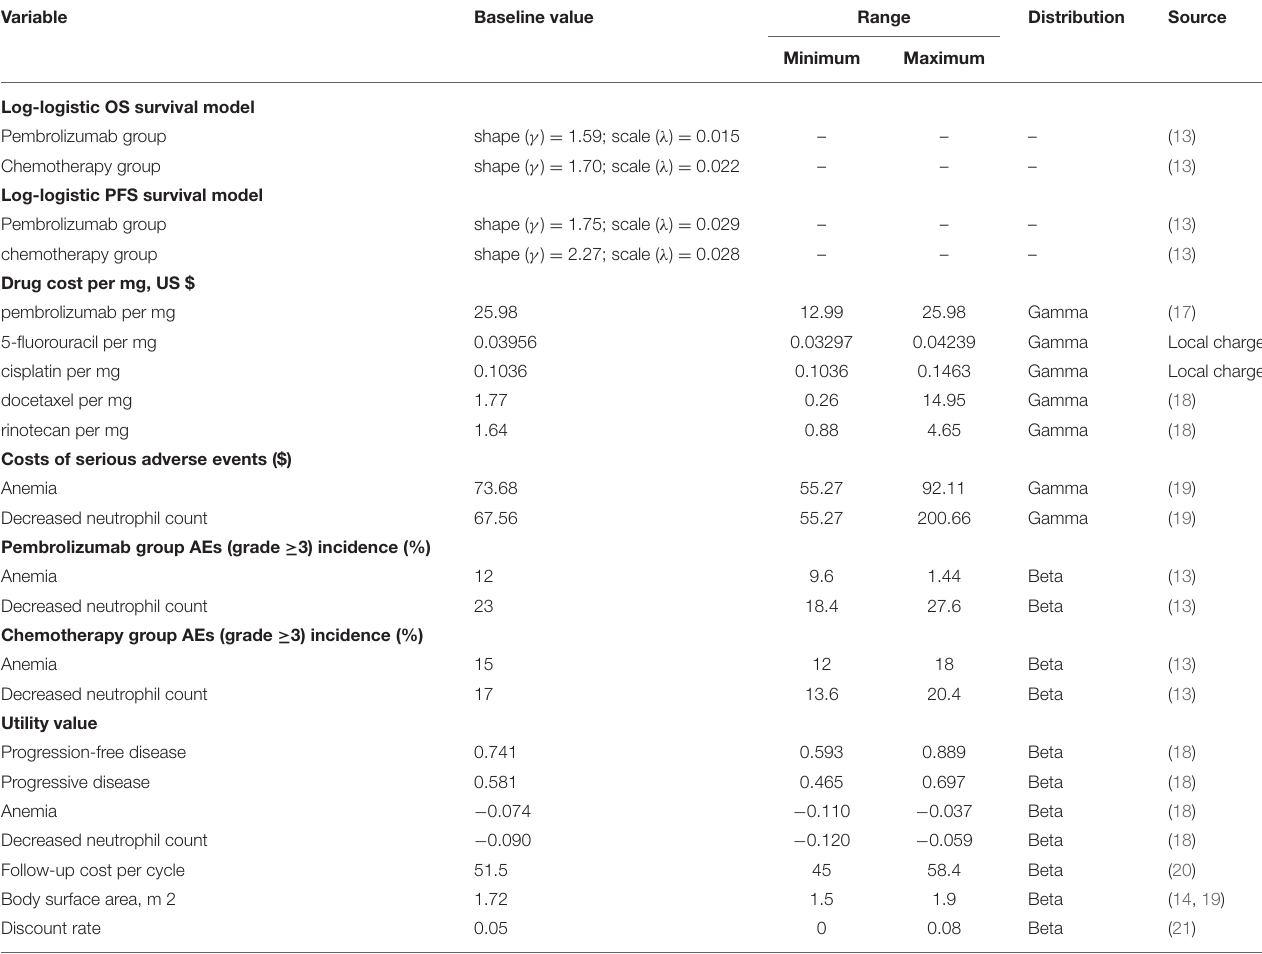
TABLE 1 | Model economic parameters and the range of the sensitivity analysis. Variable